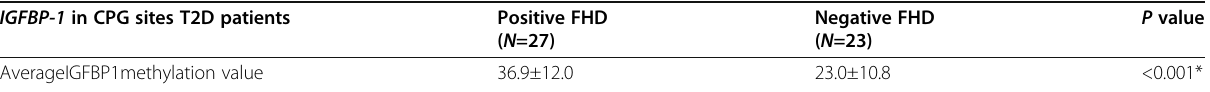
Table 3 Relation of IGFBP1 DNA methylation levels to the presence of family history of diabetes among T2D IGFBP-1 in CPG sites T2D patients